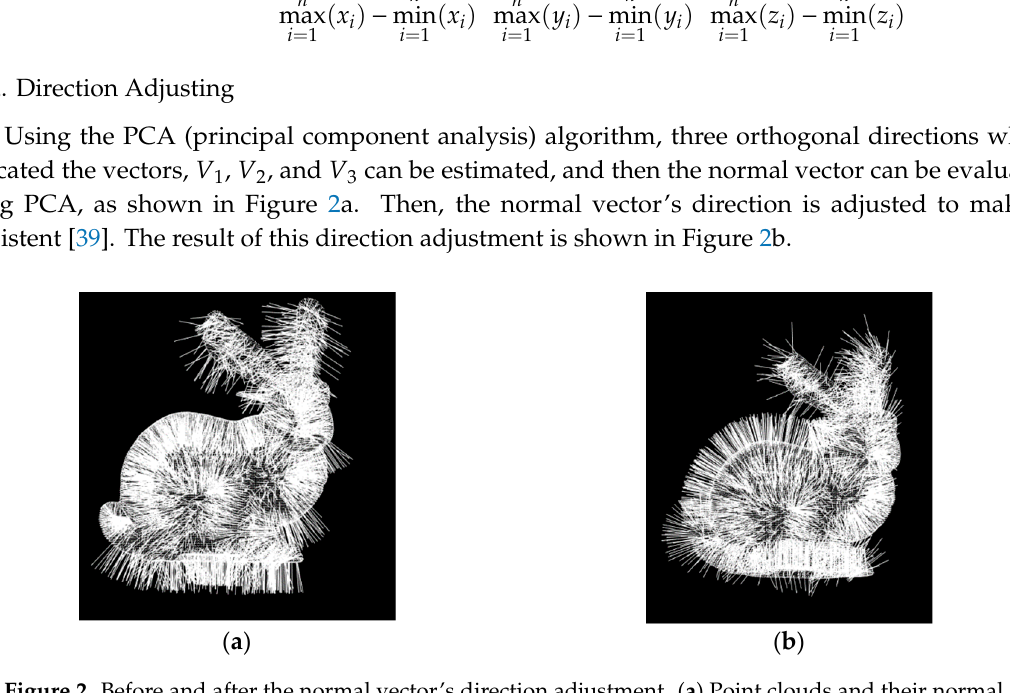
Figure 2. Before and after the normal vector’s direction adjustment. ( a ) Point clouds and their normal vectors; ( b ) point clouds and their normal vectors after normal vector direction adjustment.